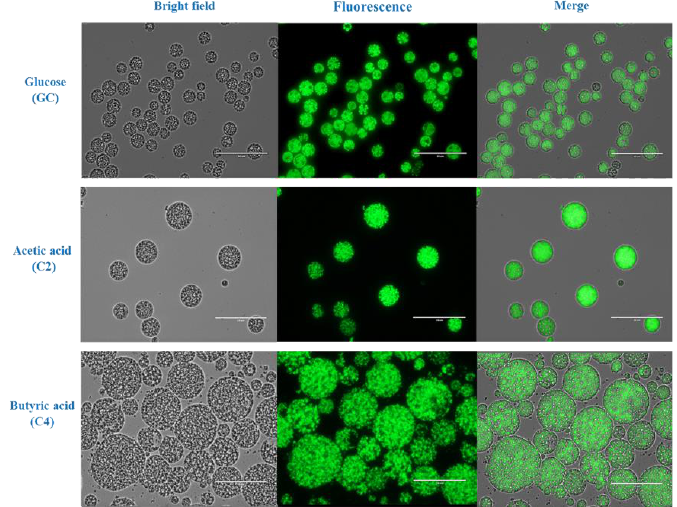
Figure 3. Morphologic analysis of cells and lipid droplets of Aurantiochytrium sp. T66 grown on 40 g/L of acetic acid, butyric acid and glucose. The cells were stained with 4,4-difluoro-1,3,5,7,8-pentamethyl-4-bora-3a,4a-diaza-s-indacene (BODIPY 493/503 ) and observed by live fluorescence microscopy. Scale bars corresponds to 50 µm.